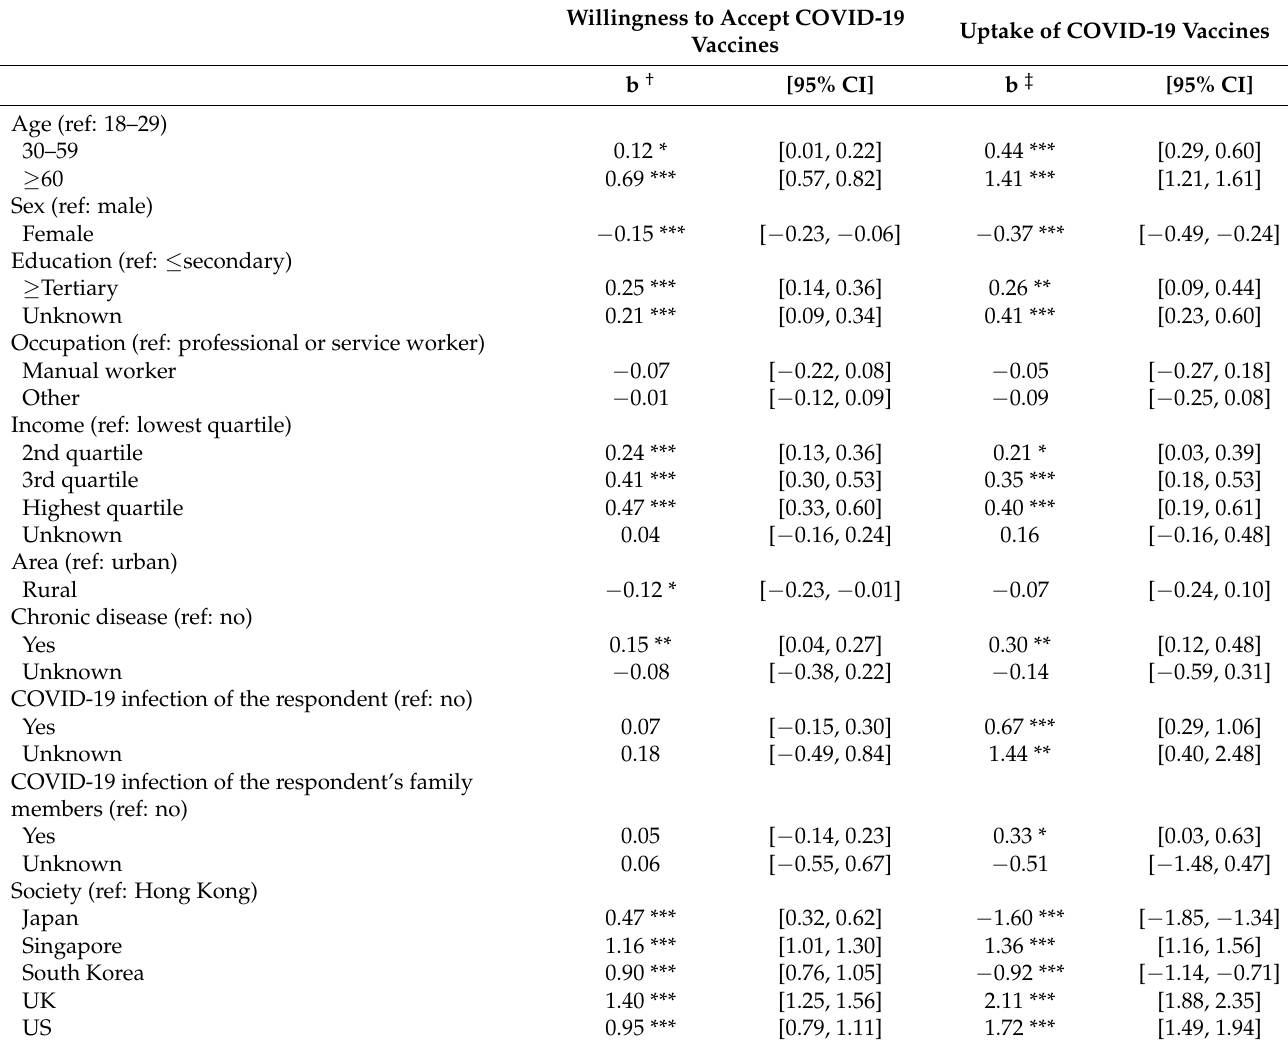
Table 2. Sociodemographic characteristics and COVID-19 vaccine hesitancy and vaccine uptake. Willingness to Accept COVID-19